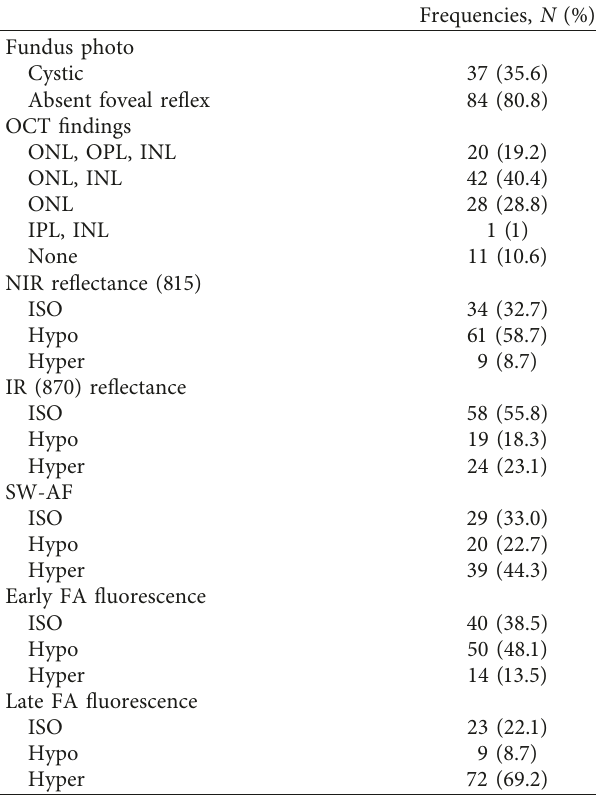
Table 2: Description of cystic diabetic macular edema patterns by different image modalities characteristics of patients with CSME.